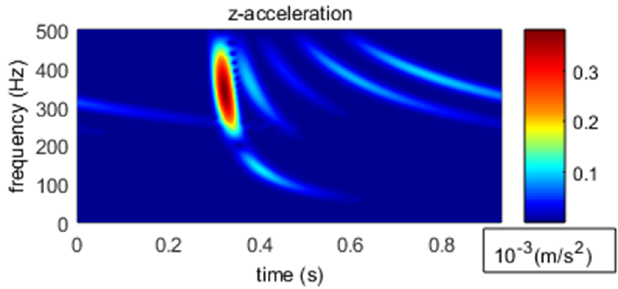
Figure 37. Time-frequency analysis of simulated seismic waves in shallow water.